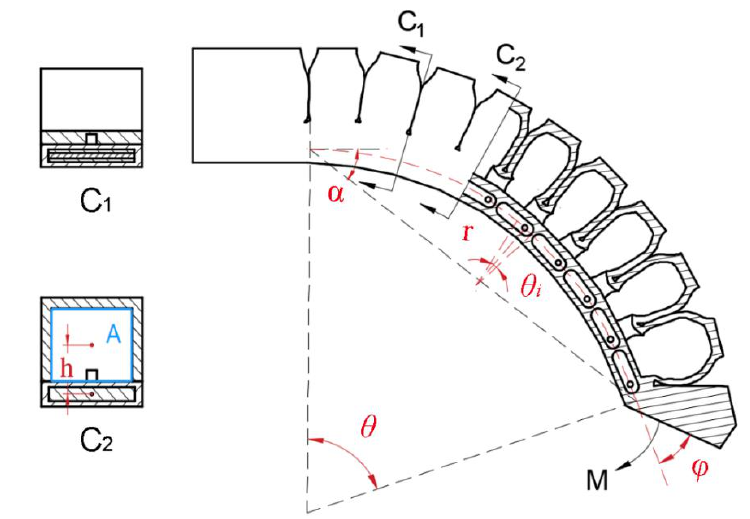
Figure 6. The deformation of a single endoskeleton finger.